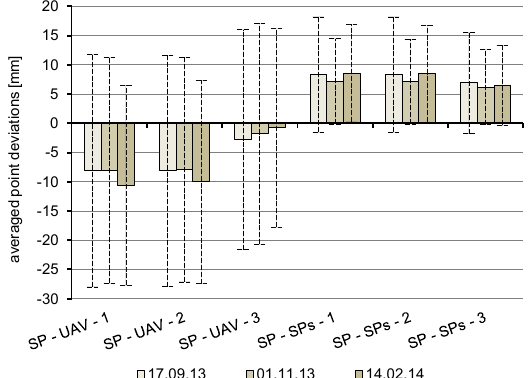
Figure 6. Result of TLS correction and co-registration of UAV and TLS data. SP-UAV-1: point deviations between UAV mesh and point clouds of individual SPs, SP-UAV-2: as SP-UAV-1 but TLS error corrected, SP-UAV-3: as SP-UAV-2 but TLS co-registered to UAV data, SP-SPs: as SP-UAV but comparison between SP and remaining SPs.